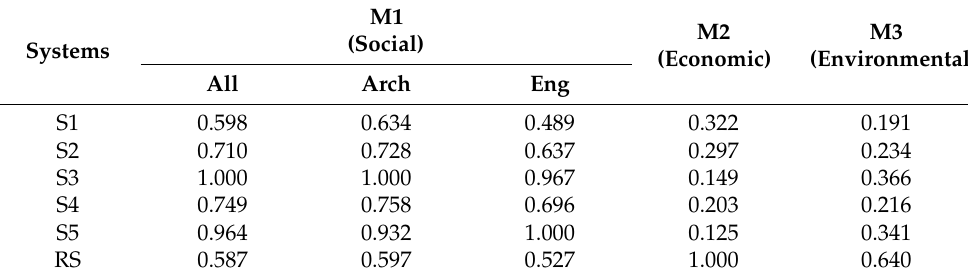
Table 10. The standardized scores.